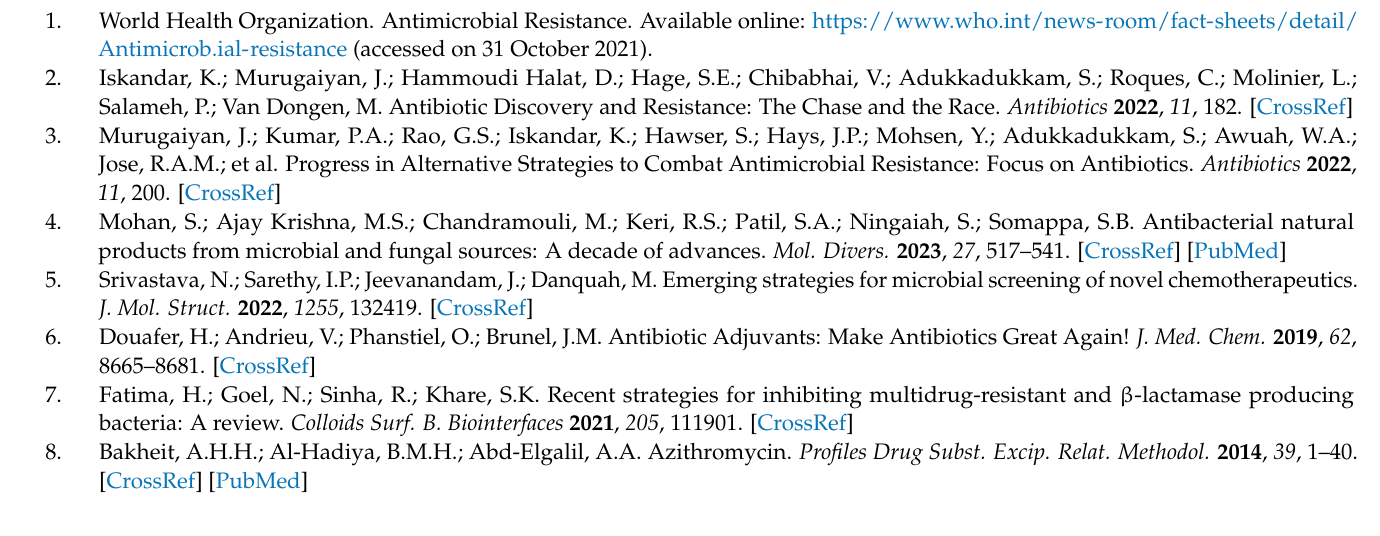
Table S2: The chemical structures of the lipids and the total electrical charge at neutral pH; Table S3: The values of the CHEMPLP evaluation function for compounds 1 – 22 and the energy contribu- tions to the formation of the ligand elongation factor (EF-G) complex; Table S4: Hydrogen bonds and nonpolar interactions of the studied ligands with amino acid residues of EF-G (4v5f) receptor; Figure S1: Location of ligands 1 (a) and 2 (b) in the ligand-binding cavity of the elongation factor (EF-G) according to the results of molecular docking; Spectral characteristics of